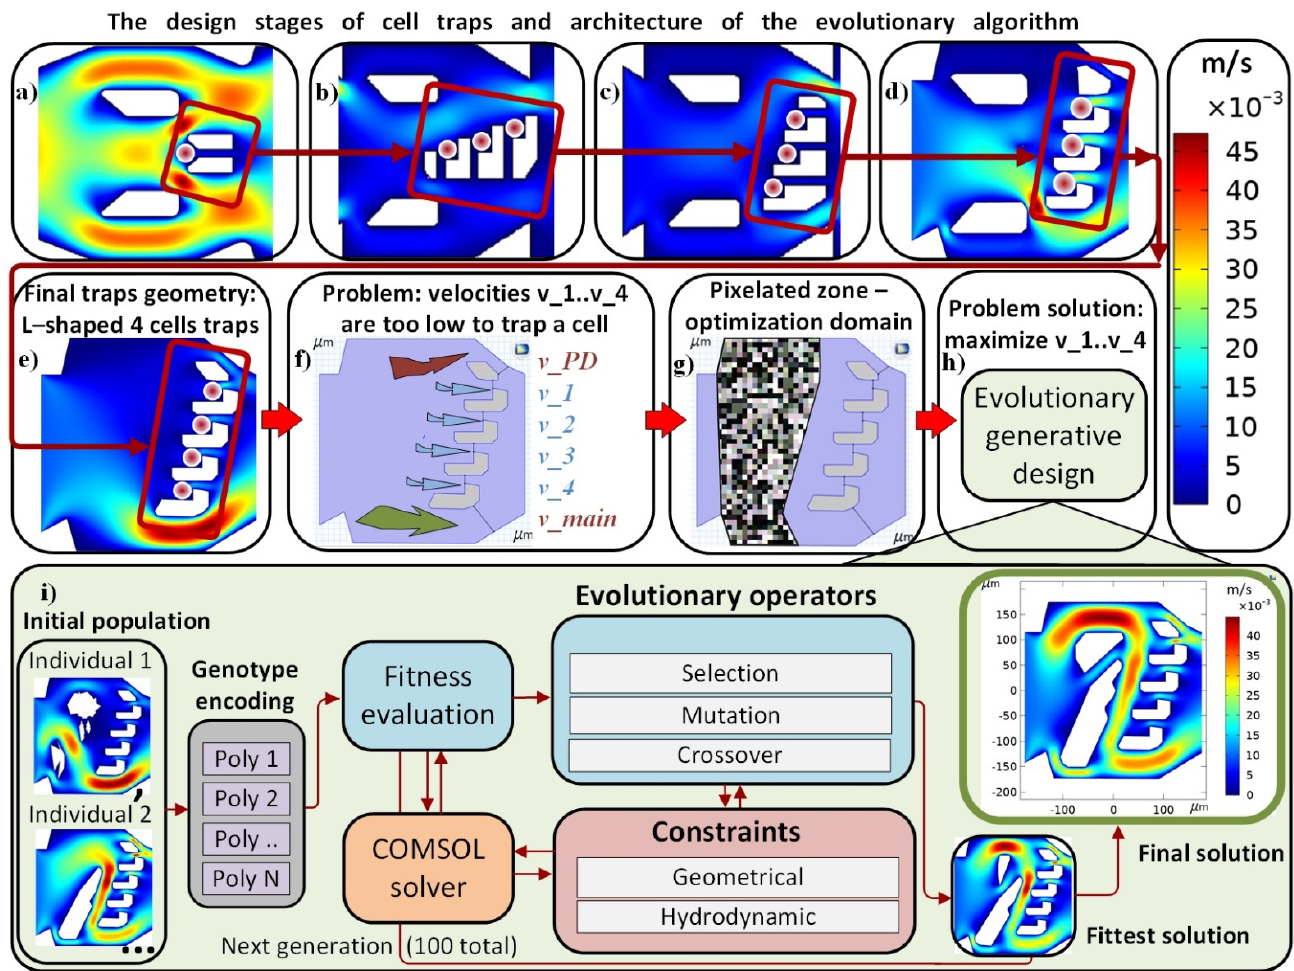
Figure 2. The design stages of cell traps and the architecture of the evolutionary algorithm. Flow direction from left to right. Red circles symbolize the RBCs. ( a – e ) are stages of cell trapping struc- tures: each L-shape trap traps one cell; red rectangle highlights the design changes of the trapping slits; ( f )—problem statement: velocities v_1…v_4 through slits have near-zero values, and almost zero flux pass through these slits; thus it is incapable of luring a cell by this configuration. Topology optimization is needed (TVR, Equation (2)) to increase the flow velocity in the slits to insure cell trappings; Red, blue, and green colors indicate the flow( g )—topology optimization domain (marked pixilated zones); ( h , i )—architecture of the evolutionary algorithm with the final design of the trap- ping chamber.